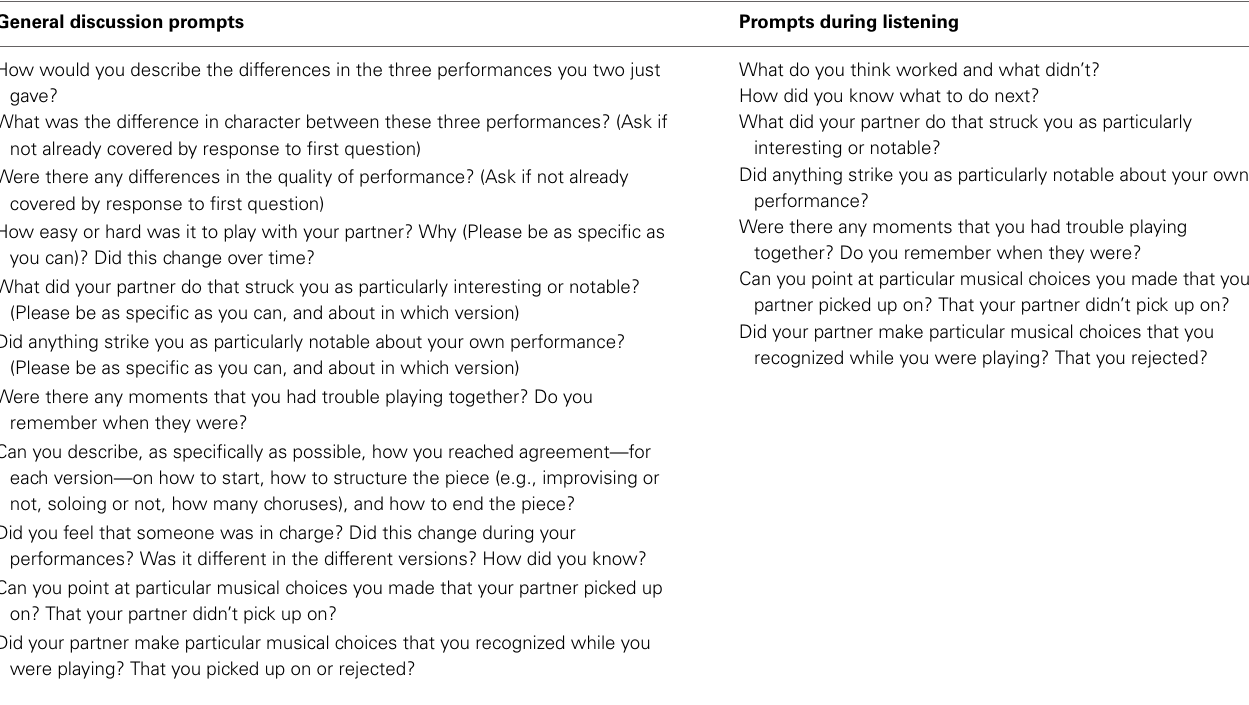
Table 1 | Interview